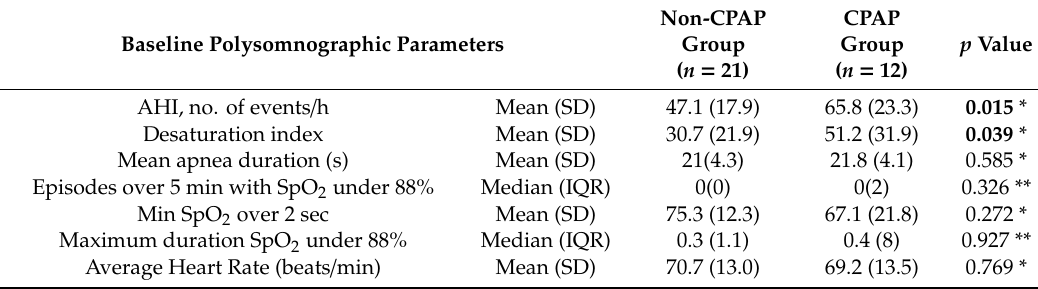
Table 2. Baseline polysomnographic parameters according to CPAP usage status at the follow-up visit.